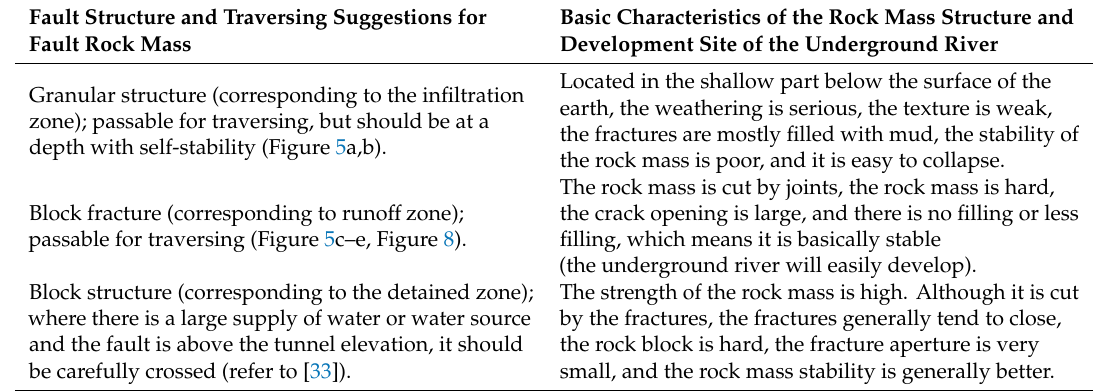
Table 2. The zoning characteristics of the fault structure with the change of depth. Fault Structure and Traversing Suggestions for Basic Characteristics of the Rock Mass Structure and Fault Rock Mass Development Site of the Underground River Located in the shallow part below the surface of the Granular structure (corresponding to the infiltration earth, the weathering is serious, the texture is weak, the fractures are mostly filled with mud, the stability of the rock mass is poor, and it is easy to